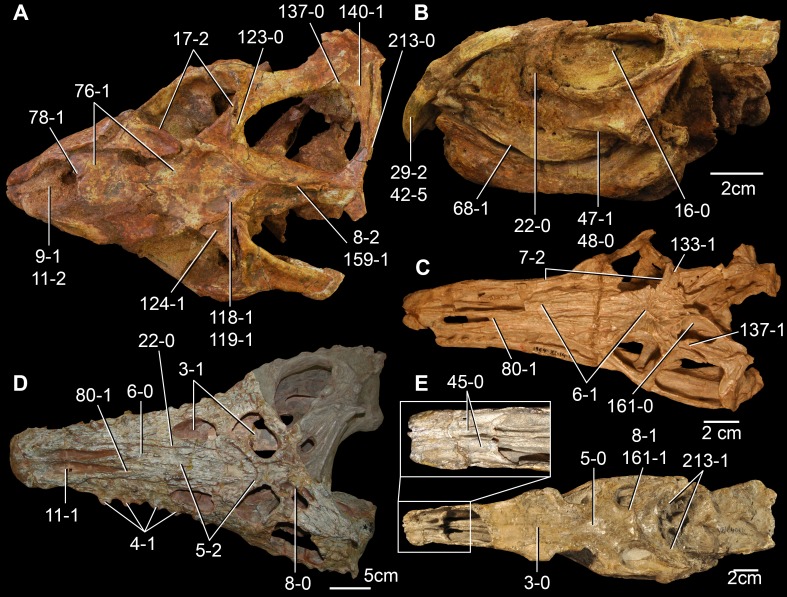
Skulls of Triassic archosauromorphs in (A, C–E) dorsal and (B) left lateral views.(A, B) Bentonyx sidensis (BRSUG 27200); (C) Chanaresuchus bonapartei (PULR 07); (D) Protorosaurus speneri (MCP 1694); and (E) Proterosuchus fergusi (BP/1/4016). Close up of the pair of septomaxillae in dorsal view in (E). Numbers indicate character-states scored in the data matrix and anterior direction is towards the left. Scale bars equal 2 cm in (A–C, E) and 5 cm in (D).